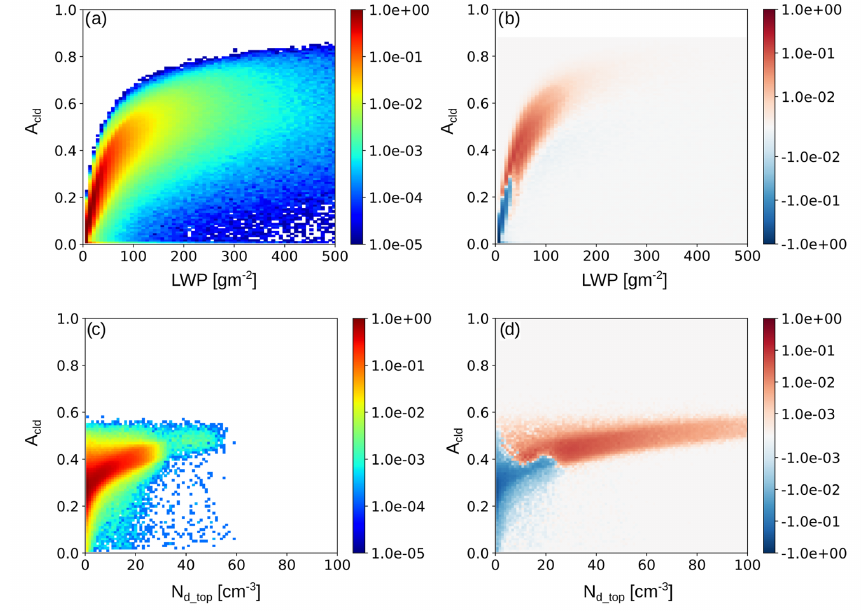
Figure 4. Occurrence rate F (%) for the (a) liquid water path (LWP) versus cloud albedo ( A cld ) phase space and (c) the cloud-top droplet number concentration ( N d_top ) versus A cld phase space. The N d_top – A cld space was sub-filtered for LWP within the range of 40–60gm − 2 . Results are shown in (a) and (c) for the last 24h of the ctrl simulation. Absolute changes in F for the ship simulation with respect to the ctrl simulation are shown in (b) and (d) respectively. F is normalised to 100% across the shown phase space. The bin widths for each of which F is defined are (cid:49) LWP: 7gm − 2 , (cid:49)N d_top : 1cm − 3 and (cid:49)A cld :